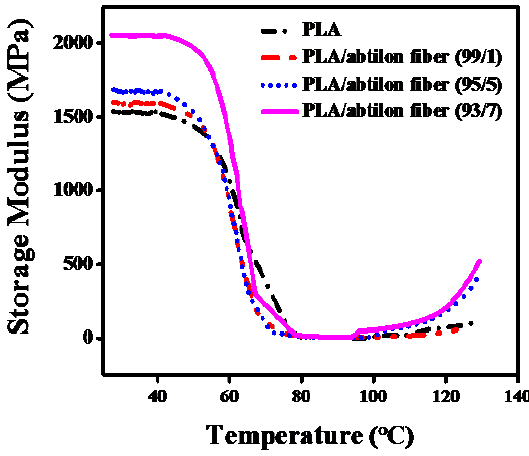
Figure 6. The storage modulus of the composite samples (PLA/abutilon fiber).